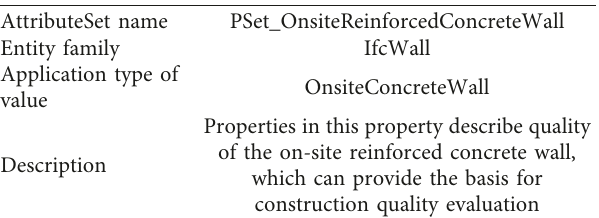
Table 8: The definition of IfcPropertySet of cast-in-place rein- forced concrete